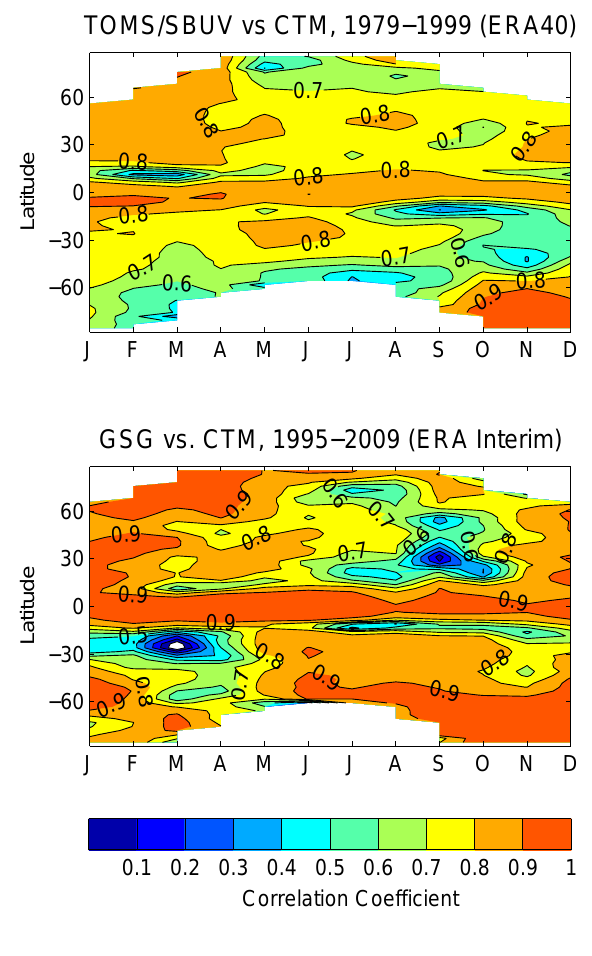
Fig. 2. Correlation between observed and modelled TO3 ( tt ) monthly mean time series: TOMS/SBUV vs. CTM in the pe- riod 1979–1999 (upper panel, model driven by ERA-40) and GOME/SCIAMACHY/GOME2 vs. CTM in the period 1990–2009 (lower panel, model driven by ERA-Interim).